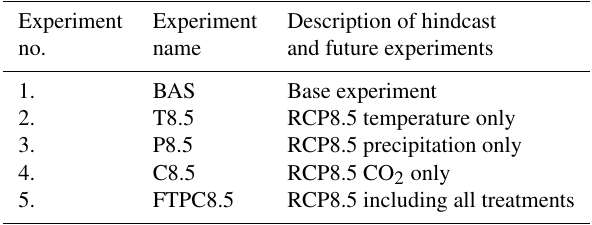
Table 2. Summary of hindcast and global change